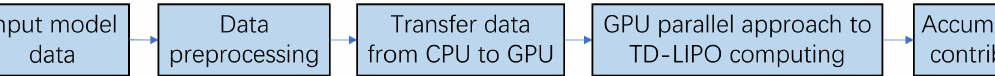
Figure 5. The process of algorithm